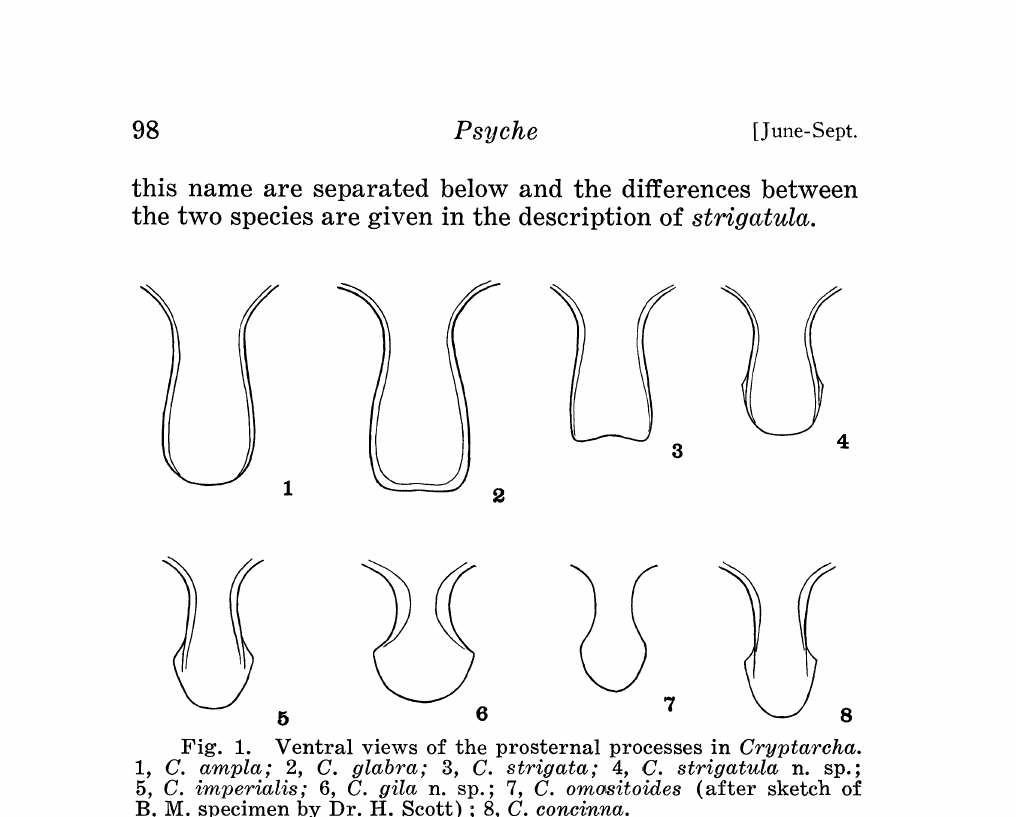
Fig. 1. Ventral views of the prosternal processes in Cryptarcha. 1, C. ampla; 2, C. glabra; 3, C. strigata; 4, C. strigatula n.